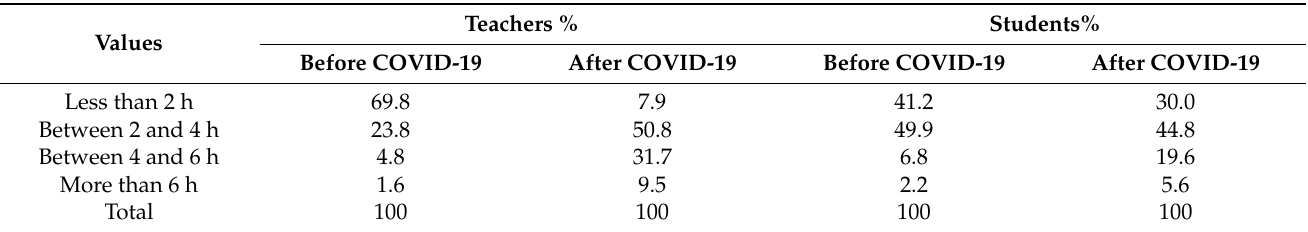
Table 9. Average daily duration allocated before the pandemic to the preparation/teaching process, after the end of online classes.